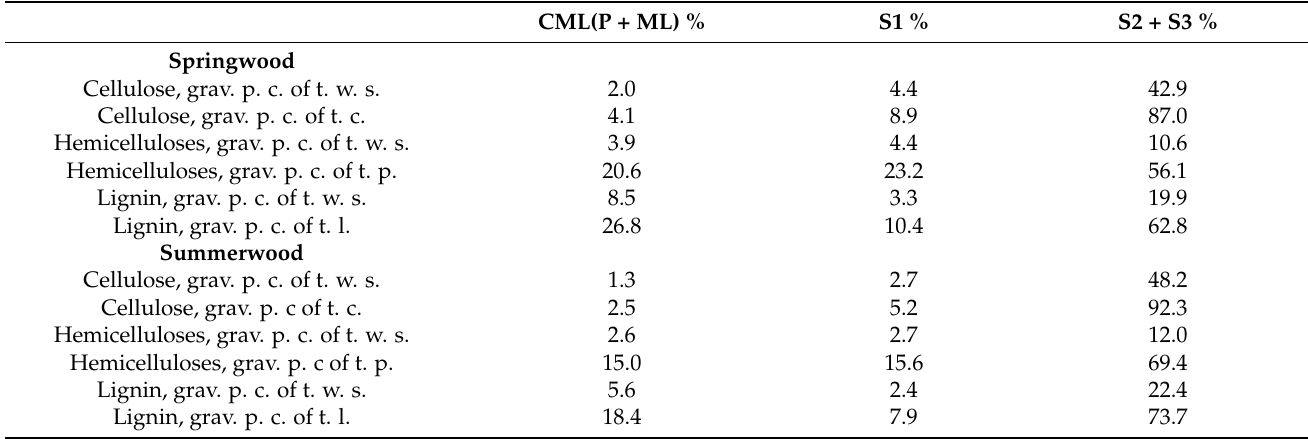
Table 2. Distribution of the chemical components in the walls of softwood tracheids (spruce). CML(P + ML) % S1 % S2 + S3